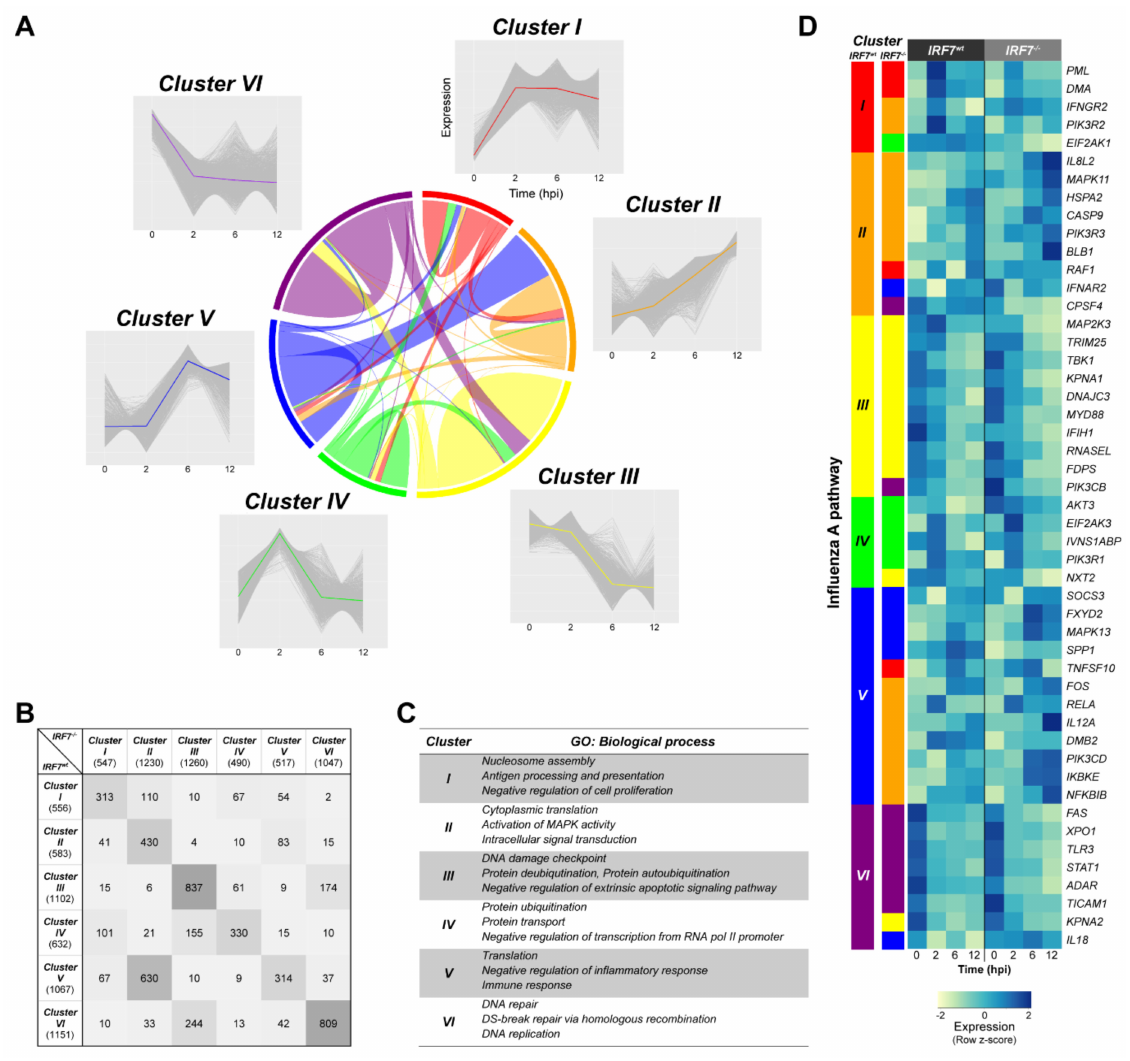
Figure 5. Gene expression profiles shifted as a result of IRF7 deletion in the host response. ( A ) The k -means clustering of di ff erentially expressed genes (DEGs; n = 5091) and expression cluster shift of genes due to IRF7 knockout. Respective gene expression is shown in gray, and the representative expression pattern is highlighted in di ff erent colors. A chord diagram indicates the number of DEGs shifted clusters from IRF7 wt to IRF7 - / - . ( B ) The number of genes in each cluster. A complete list of genes in each cluster are in Table S4. ( C ) The biological process gene ontology terms of IRF7 wt DEGs in each cluster. ( D ) DEGs in the influenza A pathway and their expression clusters between IRF7 wt and IRF7 - / - are shown on the left. The colors of the clusters correspond to the colors used in ( A ). A heatmap of gene expression of the pathway is in the right panel. See Figure S3 for each gene in the influenza A